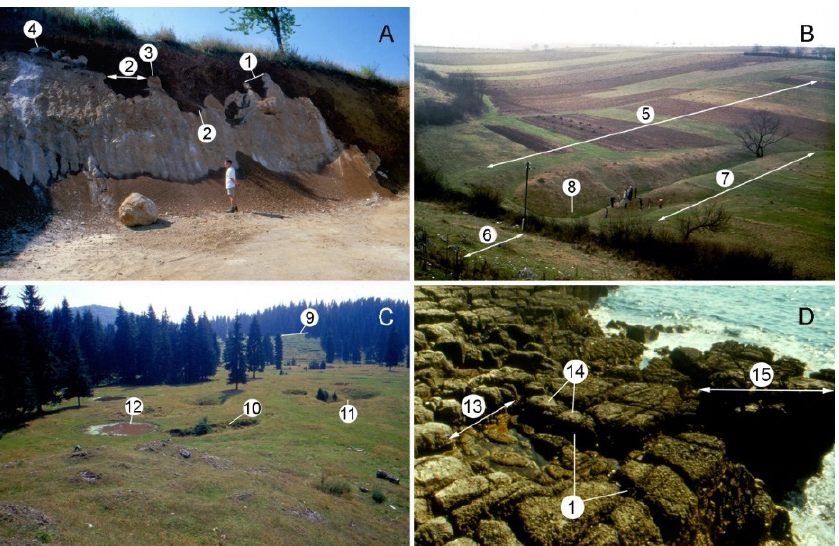
Figure 2. Azonal karsts according to rock development and altitude (photograph taken by Márton Veress): ( A ) soil-covered karst (Croatia), ( B ) mixed allogenic–autogenic karst (Aggtelek Karst, Hun- gary), ( C ) covered karst (Pádis, Romania), ( D ) coastal karst (Locrum, Croatia). Legend: 1. grike, 2. kamenitza-like depression on the floor, 3. ridge between kamenitza, 4. detached section of bedrock, 5. covered karst, 6. bare karst, 7. blind valley, 8. ponor, 9. margin of depression, 10. elongated sub-